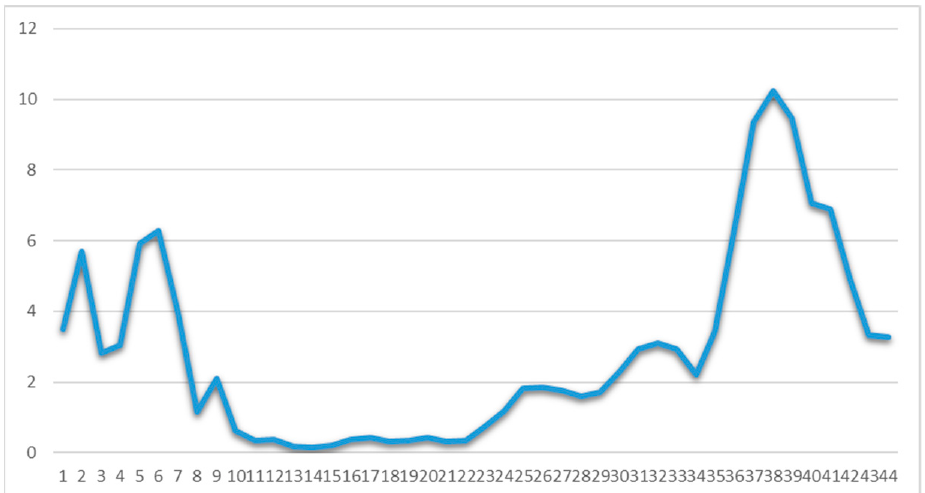
Figure 4. Weekly ratio (%) of laboratory-confirmed COVID-19 new cases to tests in Greece (Data avail- able from ECDC (https://www.ecdc.europa.eu/en/publications-data/covid-19-testing; accessed